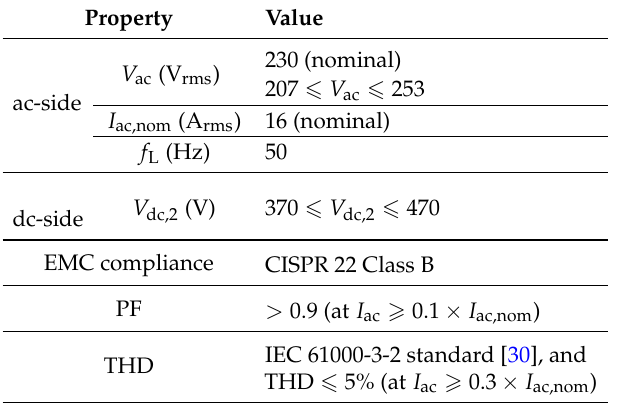
Table 1. Operating conditions and converter